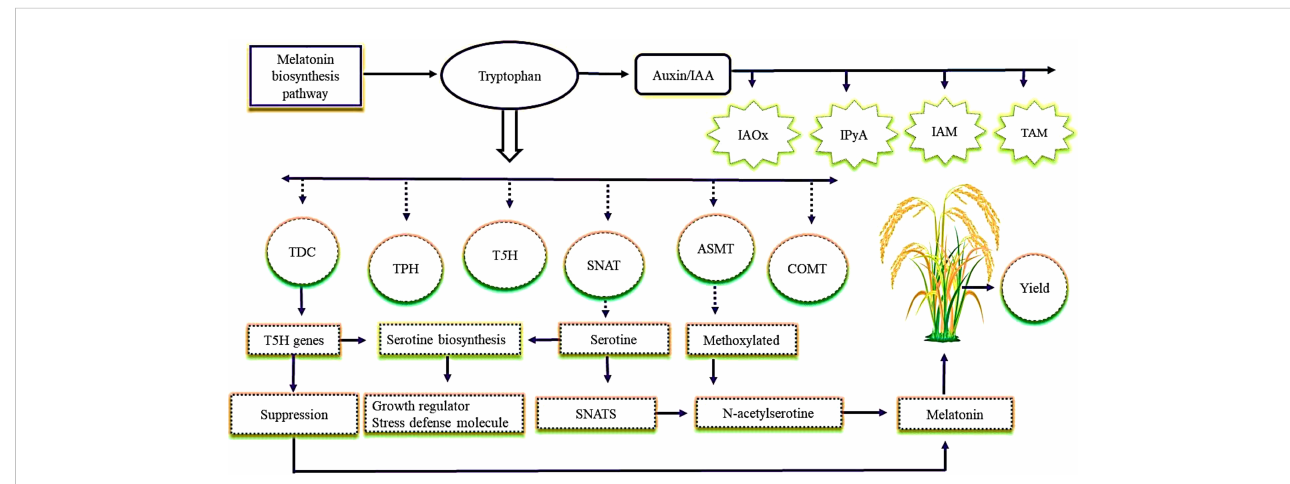
FIGURE 1 The regulatory role of biosynthetic melatonin under stress conditions. Tryptophan is the initial substrate of melatonin synthesis and is divided into four enzymatic steps catalyzed by six enzymes: tryptophan decarboxylase (TDC), tryptophan hydroxylase (TPH), tryptamine 5 ‐ hydroxylase (T5H), serotonin N ‐ acetyltransferase (SNAT), N ‐ acetylserotonin methyltransferase (ASMT), and caffeic acid O ‐ methyl transferase (COMT). Serotonin is catalyzed via SNAT to form N- acetylserotonin, which is further methoxylated by ASMTs to form melatonin and acts as a growth regulator stress defense molecule. The T5H gene improves serotonin biosynthesis. TDC catalyzes decarboxylation of tryptophan, and it is considered the fi rst step of melatonin biosynthesis. Suppression of the T5H gene increases the concentration of melatonin in rice plants and increases yield. Auxin produced naturally in plants